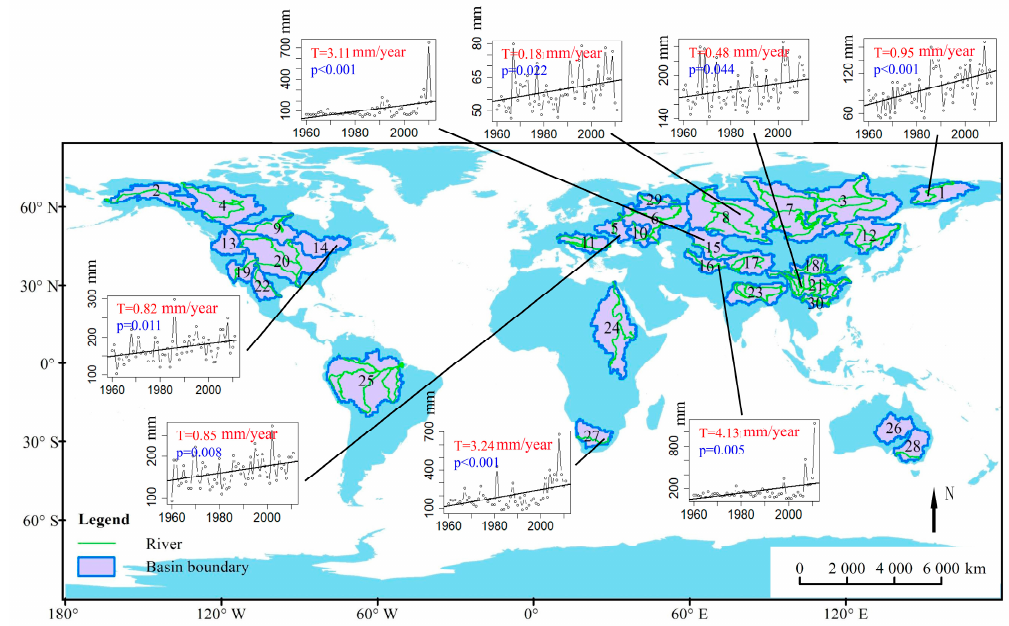
Figure 1. Trends in maximum one-day precipitation (RX1day) for different river basins. The x-axis in each panel shows the time and the y-axis is the amount of RX1day for the corresponding year. Numbers within basins signify basin ID as listed in Table 1.